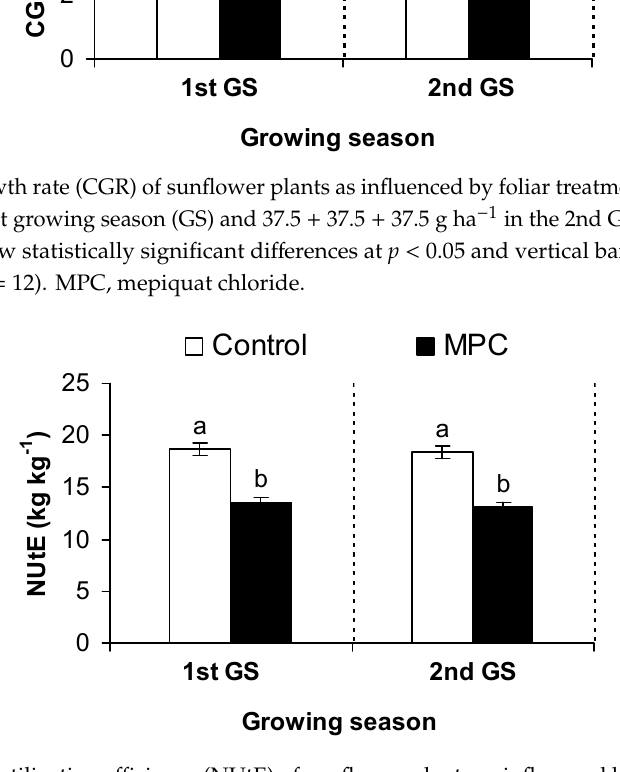
Figure 9. Nitrogen utilization efficiency (NUtE) of sunflower plants as influenced by foliar treatments of MPC (37.5 + 37.5 g ha − 1 in the 1st growing season (GS) and 37.5 + 37.5 + 37.5 g ha − 1 in the 2nd GS). Different letters within each GS show statistically significant differences at p < 0.05 and vertical bars denote standard errors of means ( n = 12). MPC, mepiquat chloride.